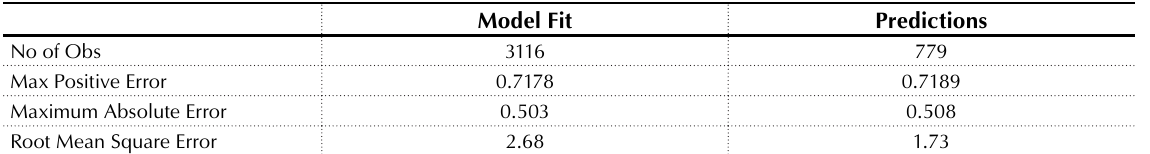
Table 7. Neural network